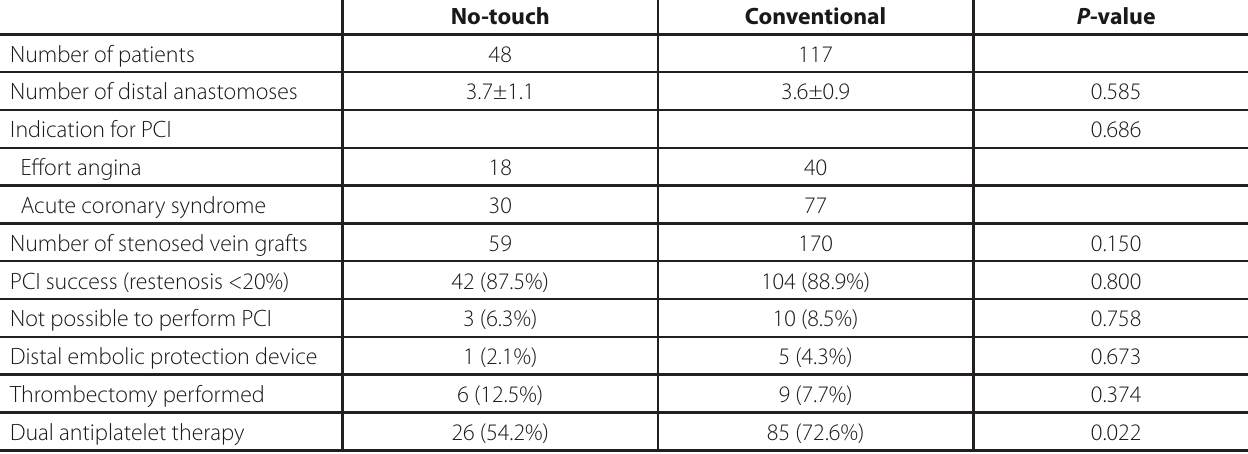
Table 2. Surgical and PCI characteristics.